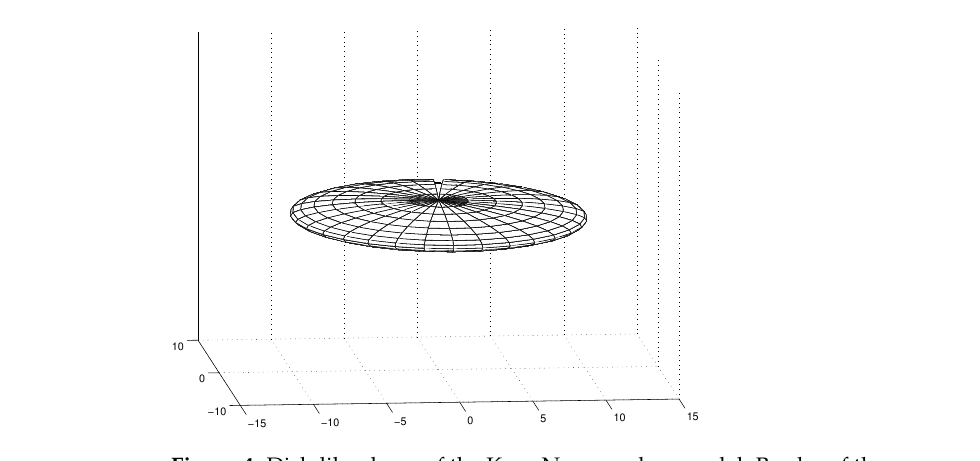
Figure 4. Disk-like shape of the Kerr–Newman bag model. Border of the superconducting bag ends with Wilson loop forming a closed circular